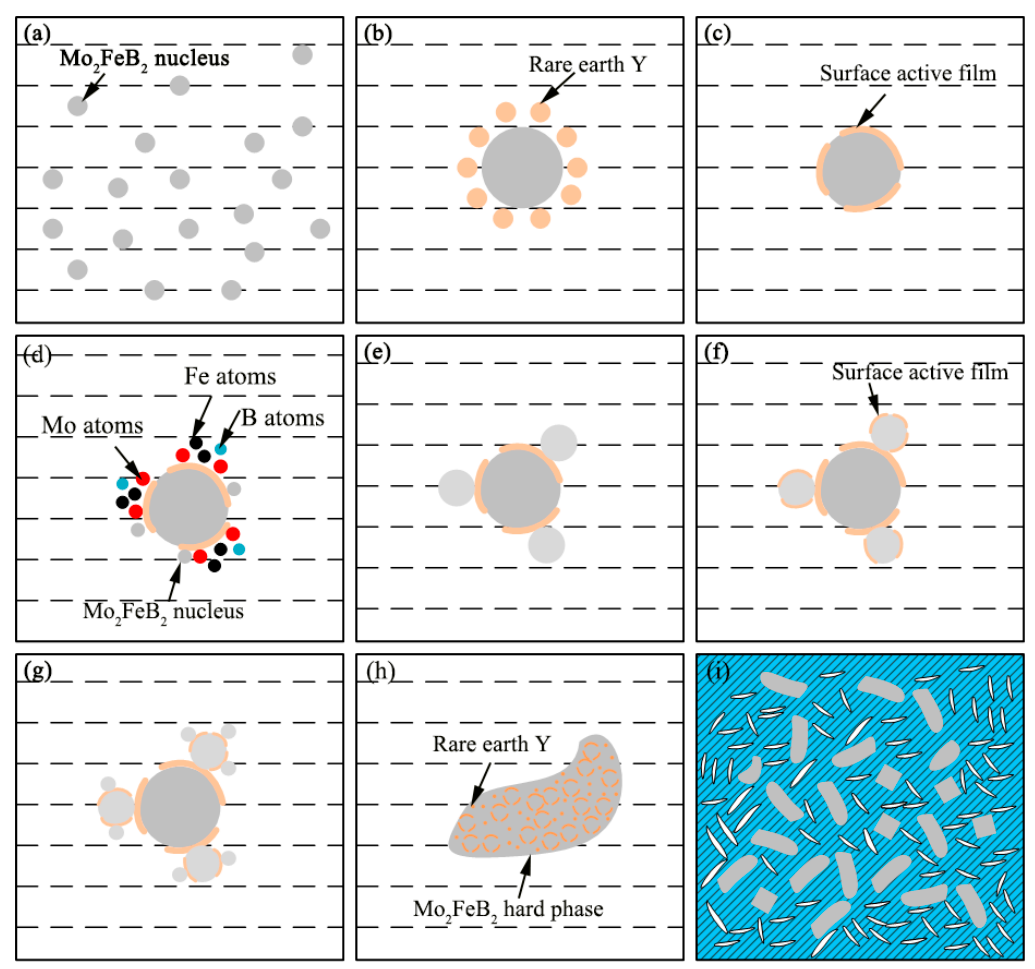
Figure 9. Schematic diagram of rare-earth action mechanism. ( a ) Nucleation process of Mo 2 FeB 2 ; ( b ) Diffusion process of Y element; ( c ) Formation process of surface-active film; ( d ) Enrichment behavior of Mo, Fe and B atoms; ( e ) Reformation process of Mo 2 FeB 2 particles; ( f ) Reformation process of surface-active film; ( g ) Reformation process of Mo 2 FeB 2 particles; ( h ) Growth process of Mo 2 FeB 2 hard phase; ( i ) Final microstructure.